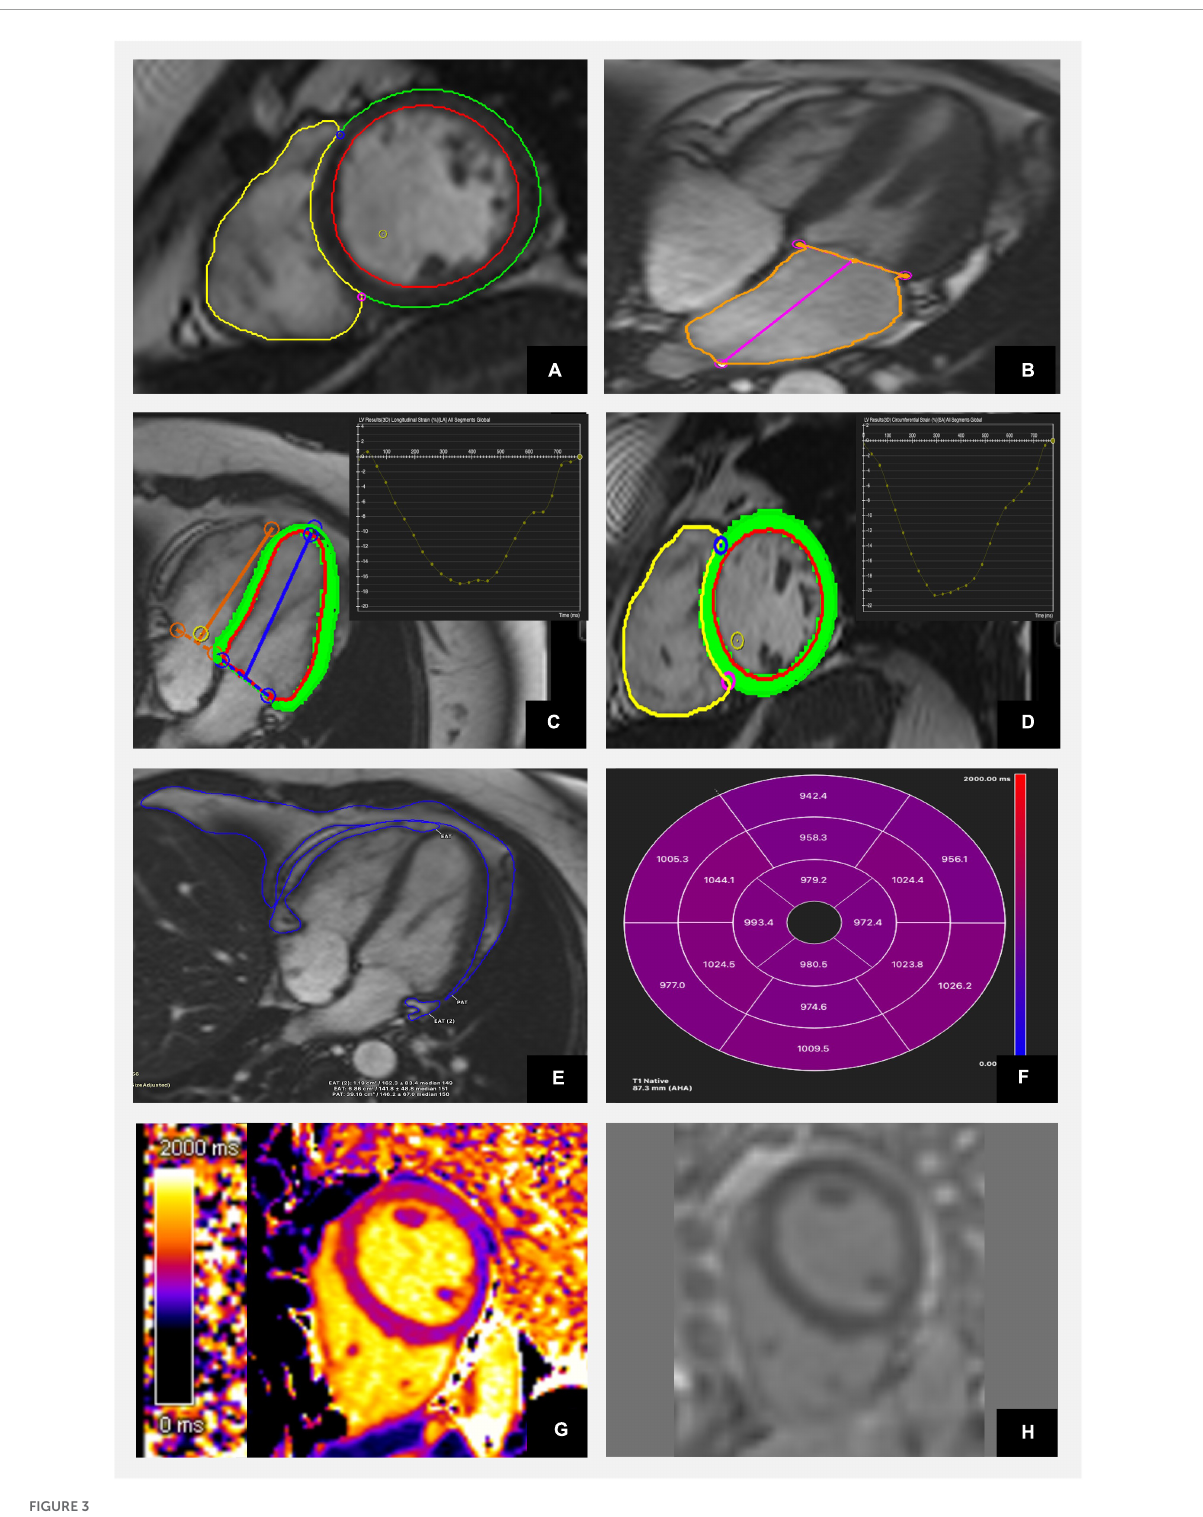
FIGURE3 Characterisation of diabetic heart disease with cardiac magnetic resonance including anatomical and functional assessment as well as tissue characterisation using CVI42 software. (A) Evaluation of LV and RV volumes and function using short axis stuck images. (B) Assessment of left atrial size. (C) Analysis of longitudinal and (D) circumferential strain. (E) Estimation of epi- and pericardial fat tissue and (F) 17 segments AHA model representation of average segmental native T1 mapping values. (G) Color map of native T1 mapping. (H) Late gadolinium images show no evidence of focal